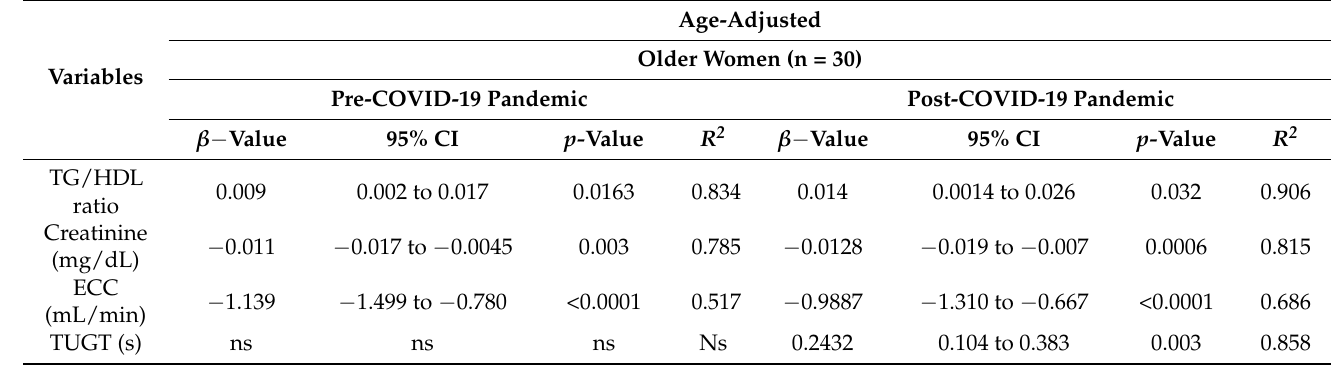
Table 4. Results of multivariate regression analysis adjusted for